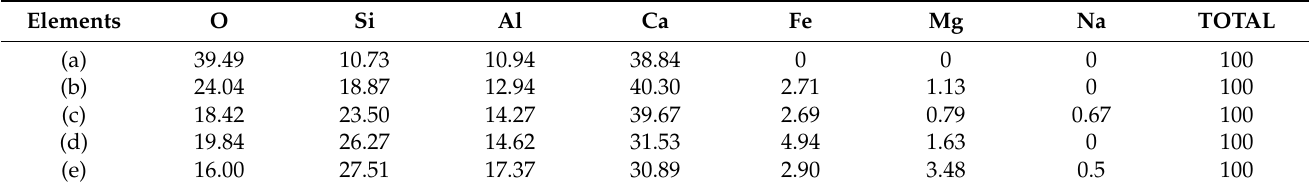
Table 3. EDS analysis of samples at different sintering temperatures: (a) 1125 ◦ C; (b) 1150 ◦ C; (c) 1175 ◦ C; (d) 1200 ◦ C; and (e) 1225 ◦